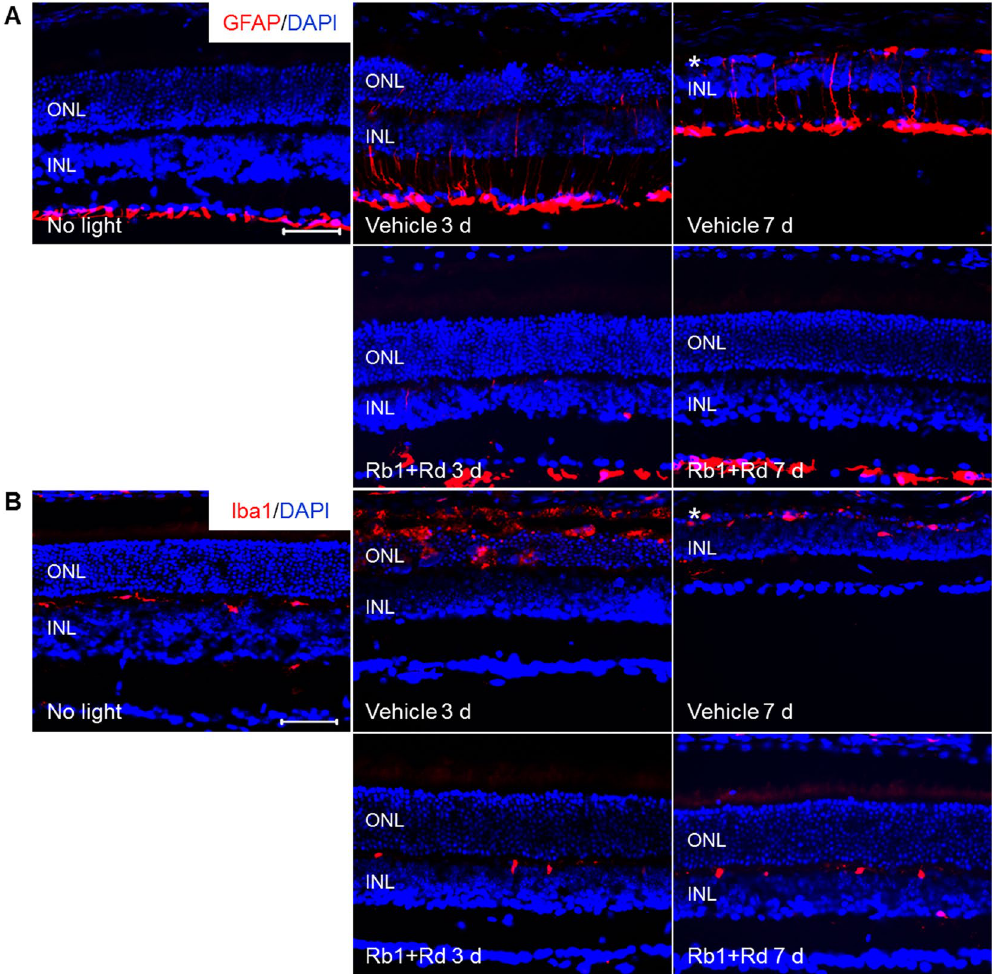
Figure 6. Combined Rb1 and Rd treatment attenuated reactive gliosis and microglia activation in bright light- exposed retina. Eyes were harvested from vehicle-treated mice unexposed to bright light (No light), bright light-exposed mice treated with vehicle (Vehicle) and combination of Rb1 and Rd 3 d and 7 d after illumination. Cryosections were made and subject to IHC examination of the retinal expression of GFAP (in red) ( A ) and Iba1 (in red) ( B ) (n = 4 per group). DAPI counterstaining (in blue) was performed in parallel. Asterisk indicated disrupted ONL. INL, inner nuclear layer; ONL, outer nuclear layer. Scale bar: 50 μ